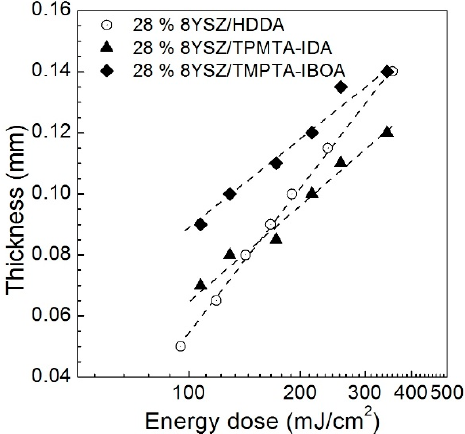
Figure 6. Layer thickness of the suspensions as a function energy dose applied.